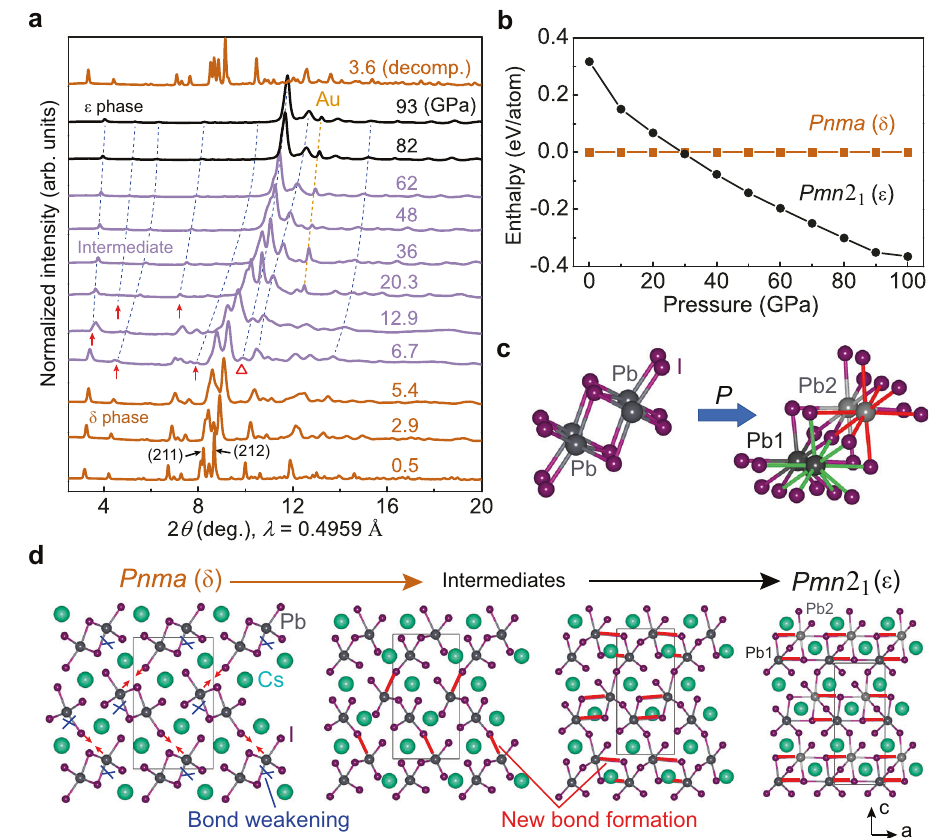
Fig. 3 | Experimental and theoretical evidence for the pressure-induced δ -to- ε structural transition in CsPbI 3 . a Selected XRD patterns of compressed CsPbI 3 showing the gradual δ -to- ε phase transition. See Supplementary Fig. 7 for the full set of XRD patterns.Theredarrowsmarktheappearanceof newdiffractionpeaks. The red triangle marks the diffraction peak at 9.8° which rapidly increases in intensity and becomes the strongest peak above 20.3GPa. The blue dashed lines indicate the evolution of the sample peak positions with pressure. The yellow dashed line tracks a diffraction peak of gold (Au) which is the internal pressure